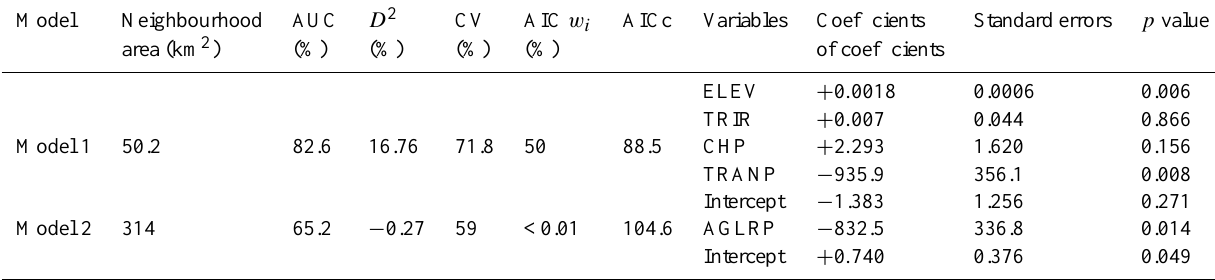
Table 2. The summary of the GLM models of estimated probability of lynx occurrences used for the Zonation analysis and the model selec- tion estimators. Model 1 composed of natural factors was used as the habitat layer in the Zonation analysis the output of model 2 composed of anthropological factors was inverted and used as the cost layer in Zonation. Neighbourhood area is the scale; AICc = corrected Akaike’s information criterion; Akaike w i = Akaike weight; D 2 = deviance explained; CV = cross validation; AUC = area under curve i . For each model the coefficients and their sign is shown along with their standard errors and statistically significance.